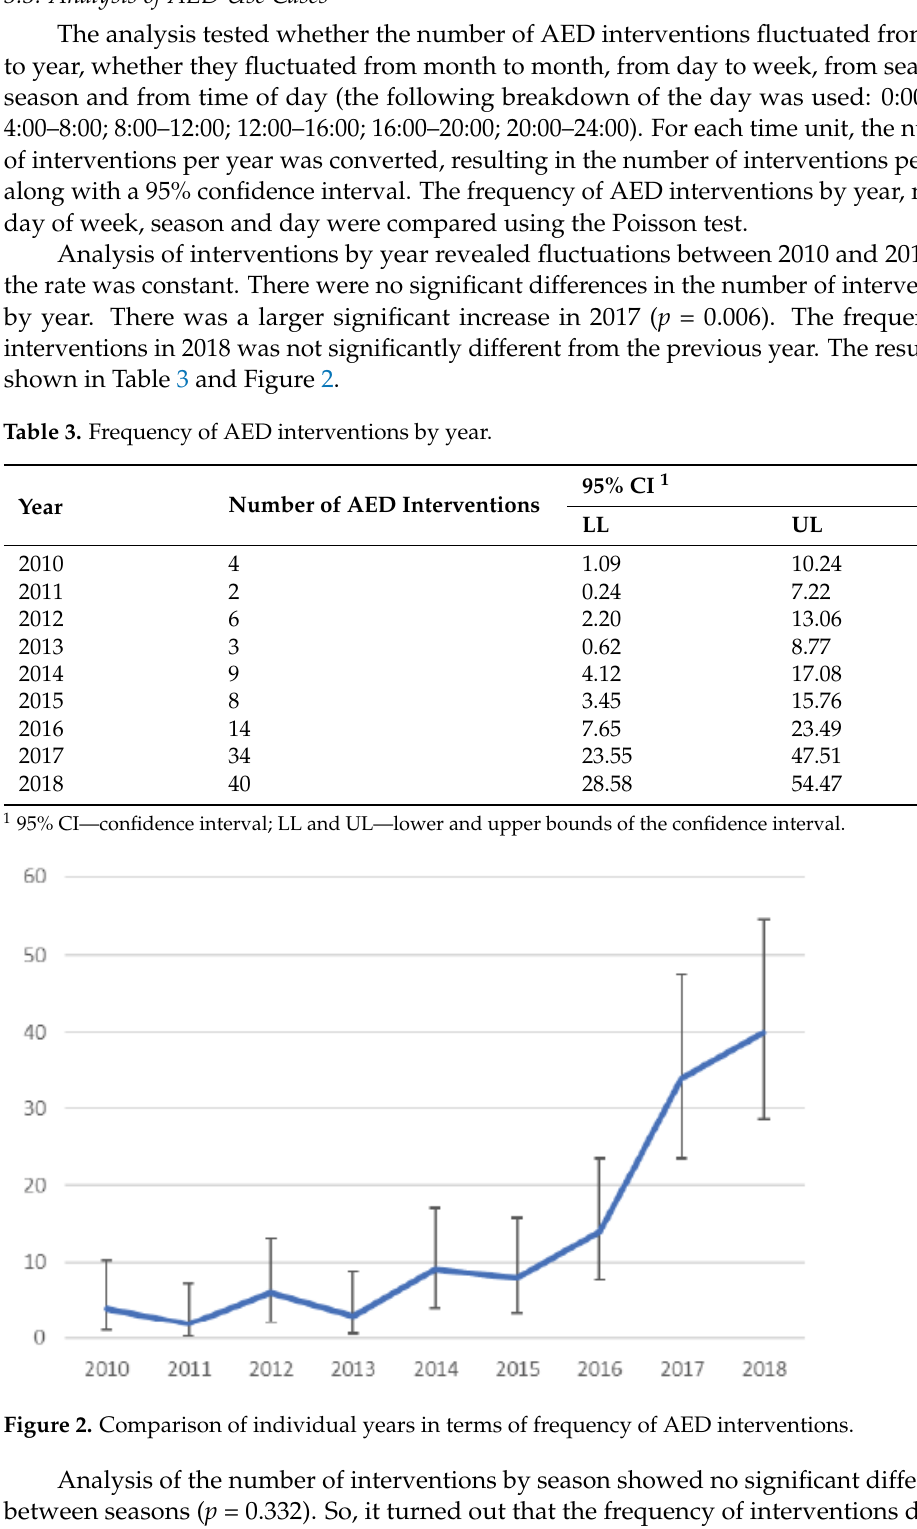
Table 4. Frequency of AED interventions by season.